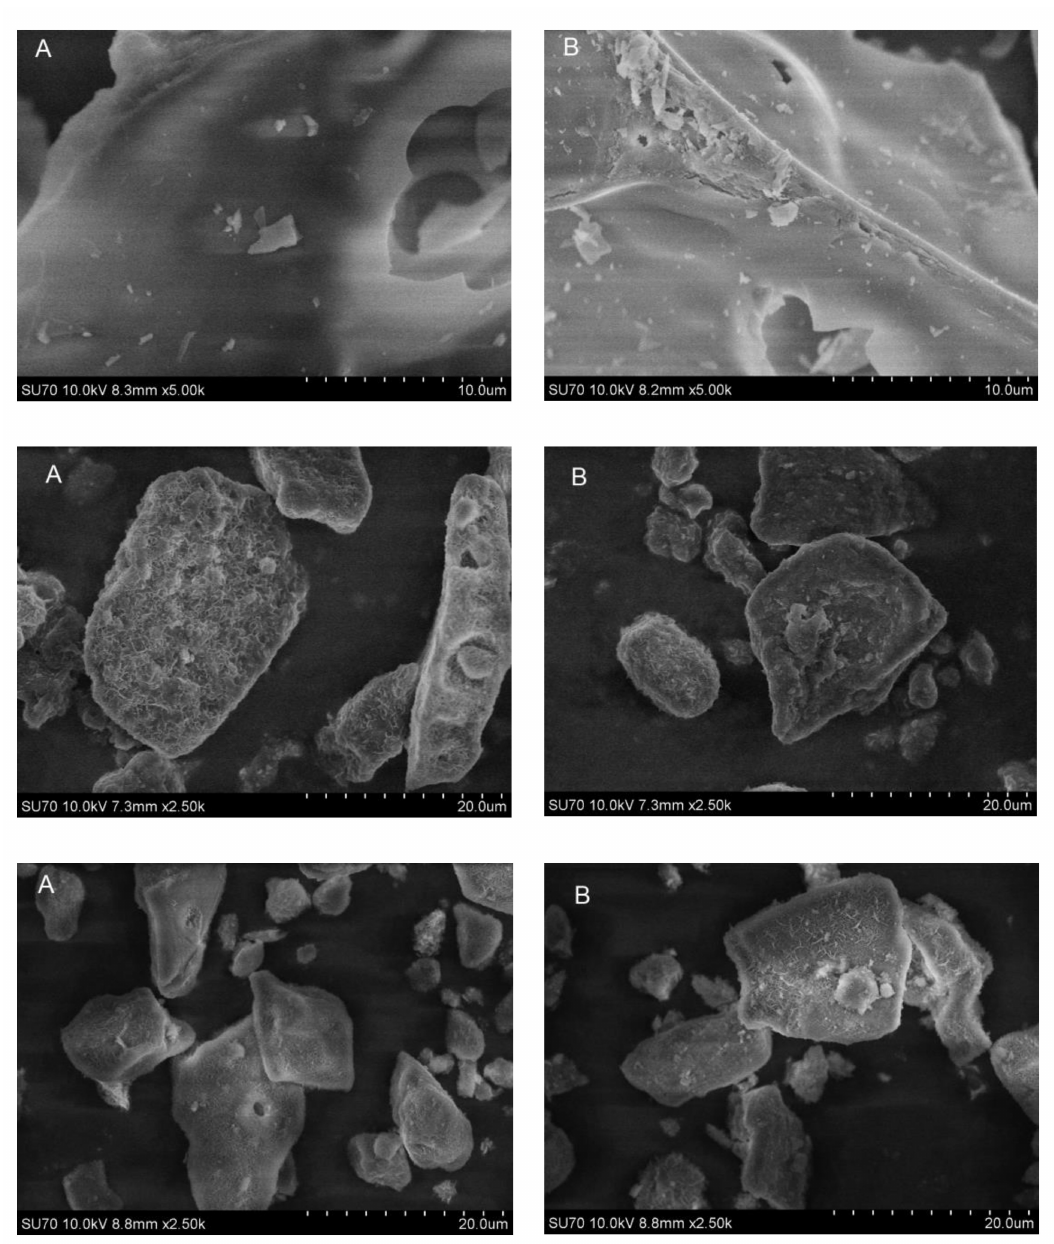
Figure 9. SEM micrographs of MMO obtained by heating the Mg 1.95 Ca 0.05 / Al 1 precursor gels ( top ), sol–gel derived Mg 1.95 Ca 0.05 / Al 1 LDHs ( middle ) and MMO obtained by heating the Mg 1.95 Ca 0.05 / Al 1 LDHs ( bottom ). Annealing temperatures: 800 ◦ C ( A ) and 950 ◦ C ( B